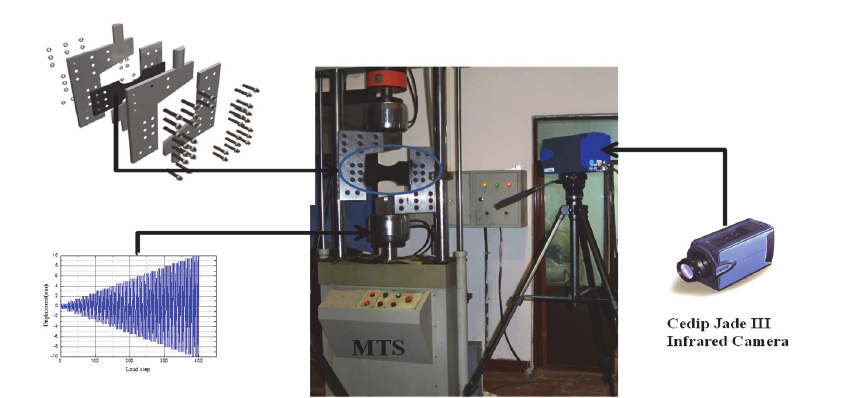
Figure 5: Load and temperature monitoring system.